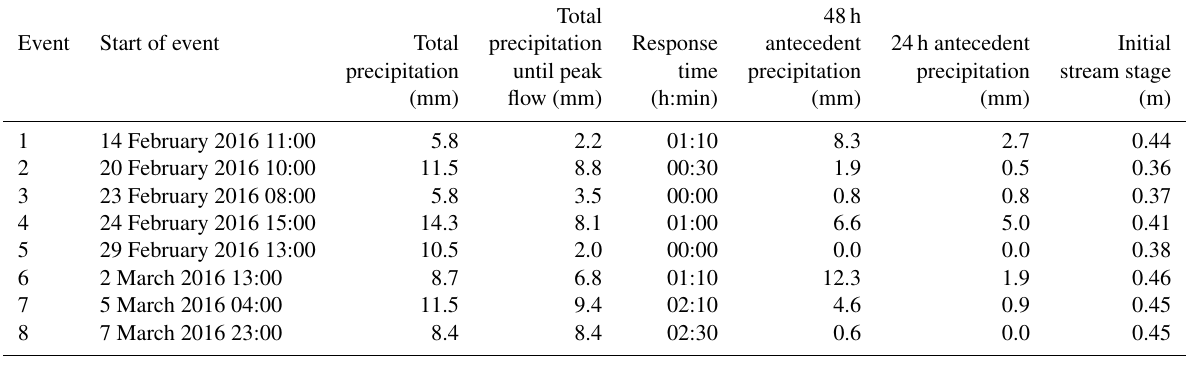
Table 2. Characteristics of precipitation events and antecedent moisture conditions during the field experiment. The initial stream stage is used here as a proxy for the initial discharge.